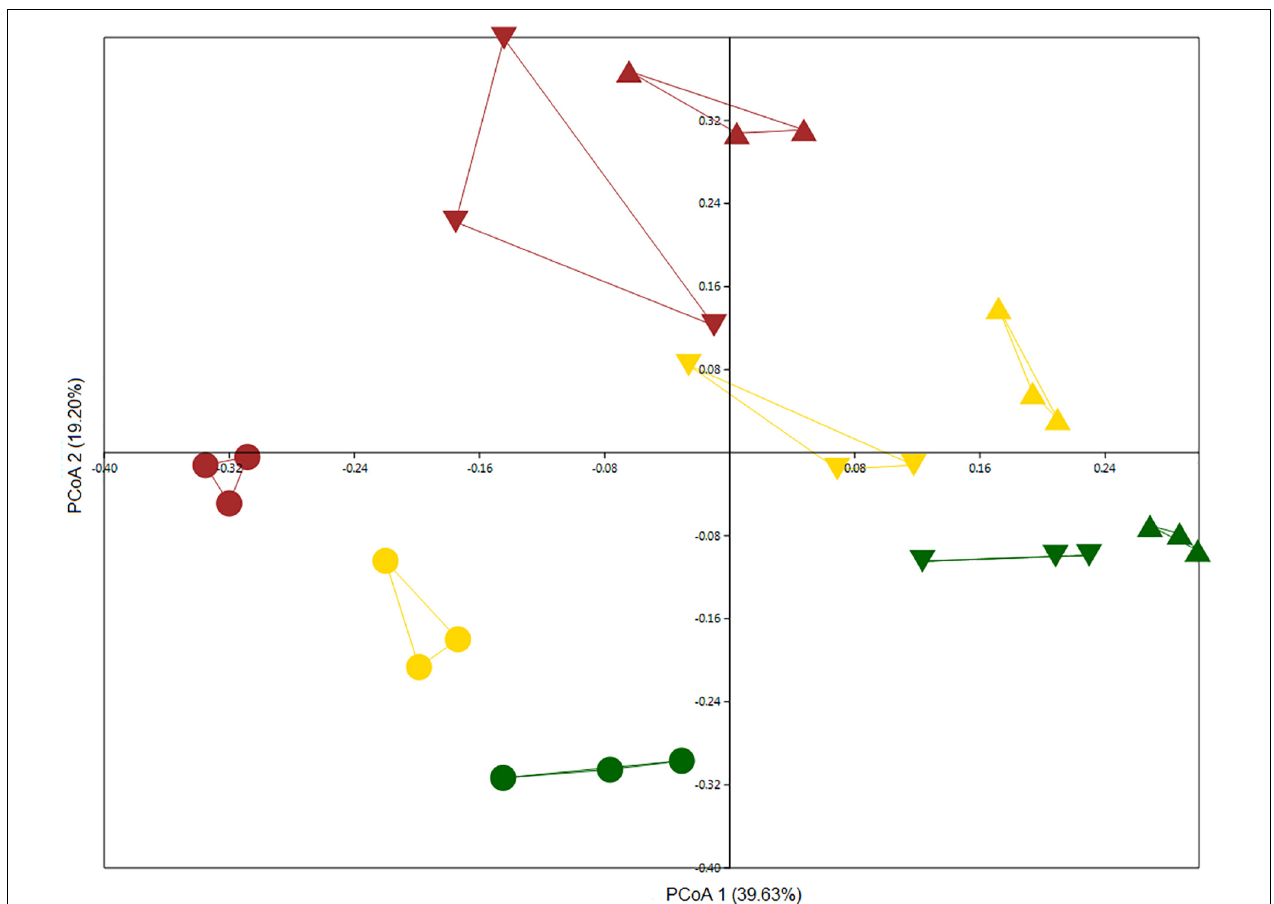
FIGURE 2 | PCoA based on Bray–Curtis distance matrix was performed on culture-independent bulk soil samples collected in 2011 (triangle) and 2013 (inverted triangle) and rhizosphere samples (circle) collected in 2012 showing the structure of bacterial communities from the Highfield experiment under three types of land management: continuous arable (yellow), conversion of bare fallow to arable (brown), and conversion of grassland to arable